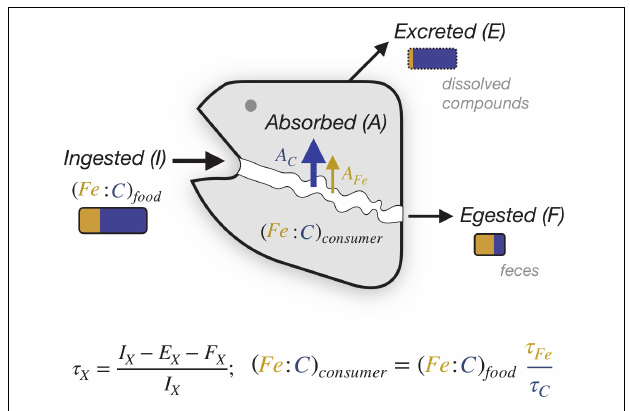
FIGURE 2 | Elemental transfer from food to animal. The gray shape represents an animal that, for an element X, incorporates in biomass a lifetime-averaged fraction τ X of the total ingested elemental flux I X . This differs from the absorbed flux A X (also termed gut assimilation) due to the excretion flux E X . Orange and blue rectangles illustrate the approximate relative changes expected for Fe and C, respectively, between food, feces and excretion for a growing animal. Note that feces may also include dissolved